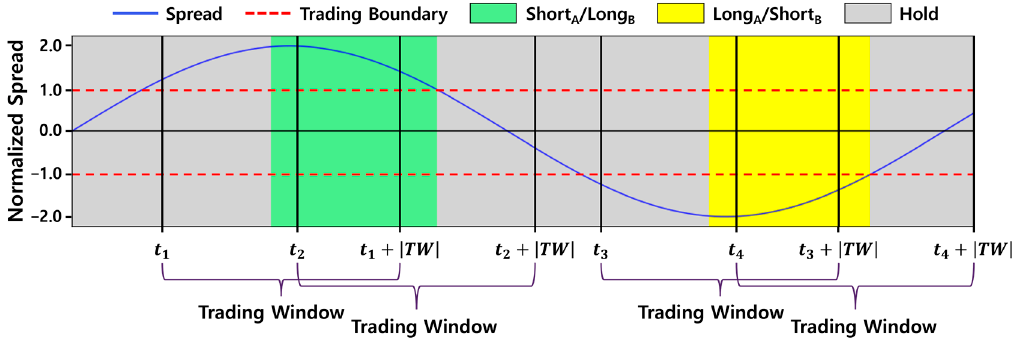
Figure 6. An example of the expert’s actions.